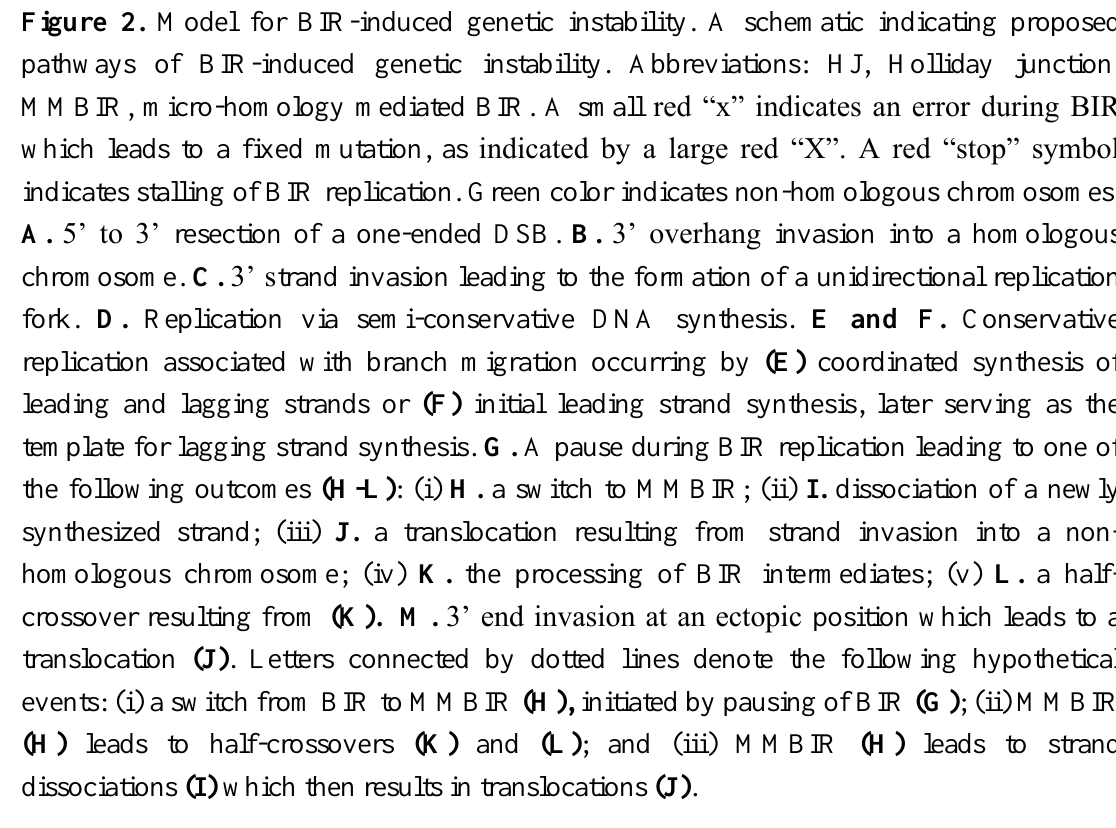
Figure 2. Model for BIR-induced genetic instability. A schematic indicating proposed pathways of BIR-induced genetic instability. Abbreviations: HJ, Holliday junction; MMBIR, micro-homology mediated BIR. A small red “x” indicates an error during BIR which leads to a fixed mutation, as indicated by a large red “X”. A red “stop” symbol indicates stalling of BIR replication. Green color indicates non-homologous chromosomes. A. 5’ to 3’ resection of a one-ended DSB. B. 3’ overhang invasion into a homologous chromosome. C. 3’ strand invasion leading to the formation of a unidirectional replication fork. D. Replication via semi-conservative DNA synthesis. E and F.